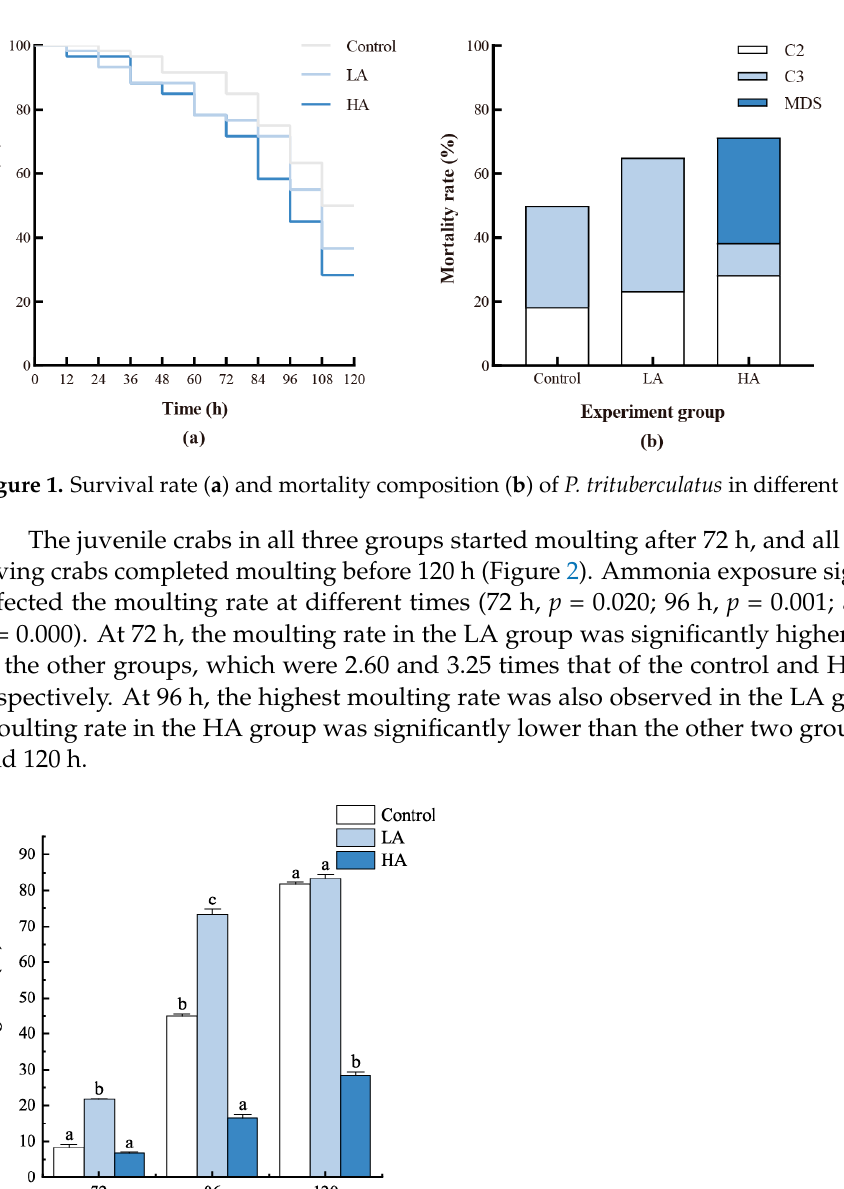
two groups from 48 h to 96